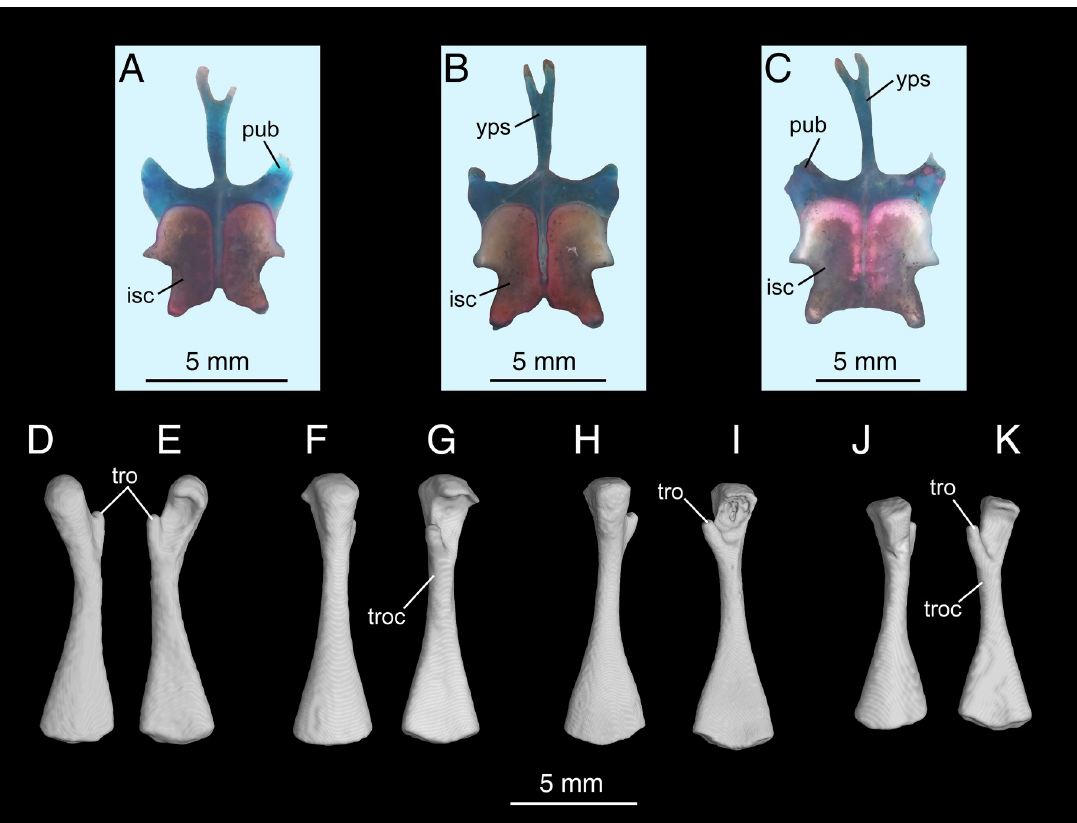
Fig 12. Micro-CT rendered reconstructions of the ypsiloid cartilage and femur of Batrachuperus yenyuanensis . Ypsiloid cartilage in dorsal view in CIB 201707YY04 (A), CIB 201707YY08 (B), CIB 201707YY09 (C); right femur of CIB 14514 (D, E), CIB 16999 (F, G), CIB 17308 (H, I) and CIB 94632 (J, K) in dorsal (left) and ventral (right) views. CIB 14514 from Maoniudui, Dechang County; CIB 16999 from Shenguozhuang, Yuexi County; CIB 17308, 201707YY04, 201707YY08 and 201707YY09 from Shuangertang, Yanyuan County; CIB 94632 from Xieka, Jiulong